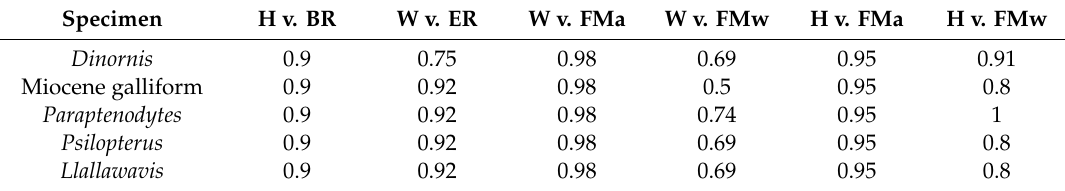
Table 3. Resulting p -values of the phylogenetic ANCOVA comparing the intercept of each extinct member of the sample to the intercept of the rest of the sample, given a common slope. These p -values have been adjusted with the Benjamini and Hochberg [89] procedure to control for false discovery rate; unadjusted p -values are available in Table S3. Abbreviations: BR, brain-remainder volume (brain volume minus optic-tectum volume); ER, endocast-remainder surface area (endocast surface area minus optic-lobe surface area); FMa, foramen-magnum area; FMw, foramen-magnum width; H, hyperpallium volume; W, Wulst surface